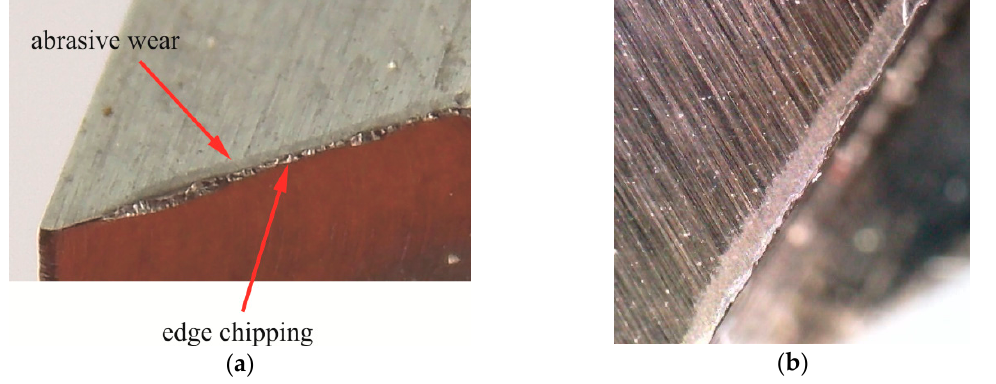
Figure 22. The punch after blanking out about 60,000 hooks with a clearance of 10%: ( a ) A fragment of the blanking edge of the punch with visible chippings and ( b ) abrasive wear on the face close to the blanking edge.